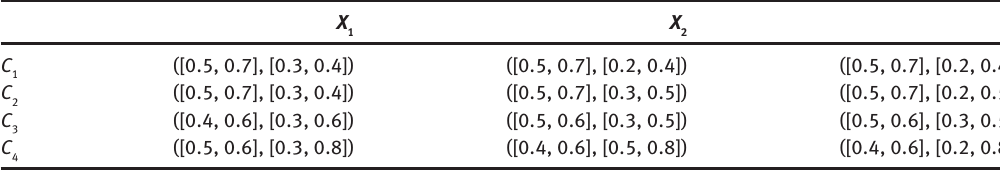
Table 10: Pythagorean Fuzzy Ordered Decision Matrix R 3 .